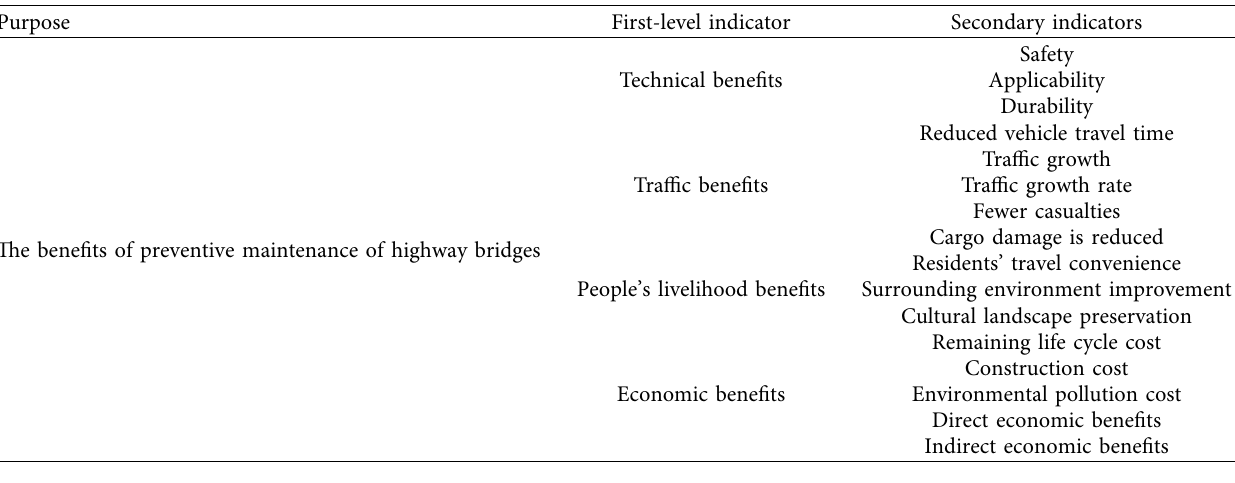
Table 1: Evaluation system of preventive maintenance of highway